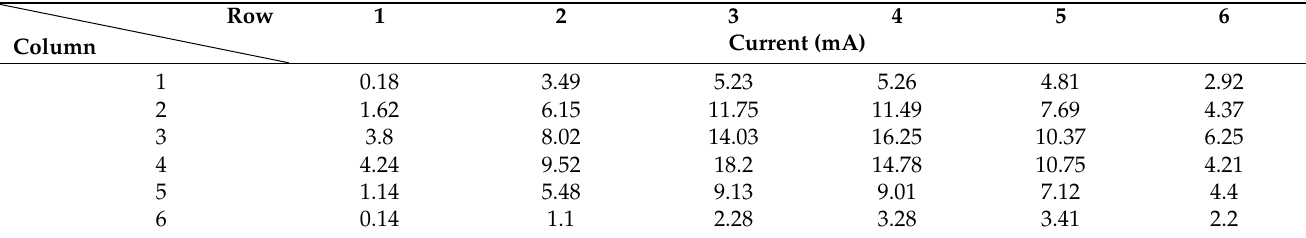
Table 4. The currents of the photovoltaic cells irradiated by the 808 nm